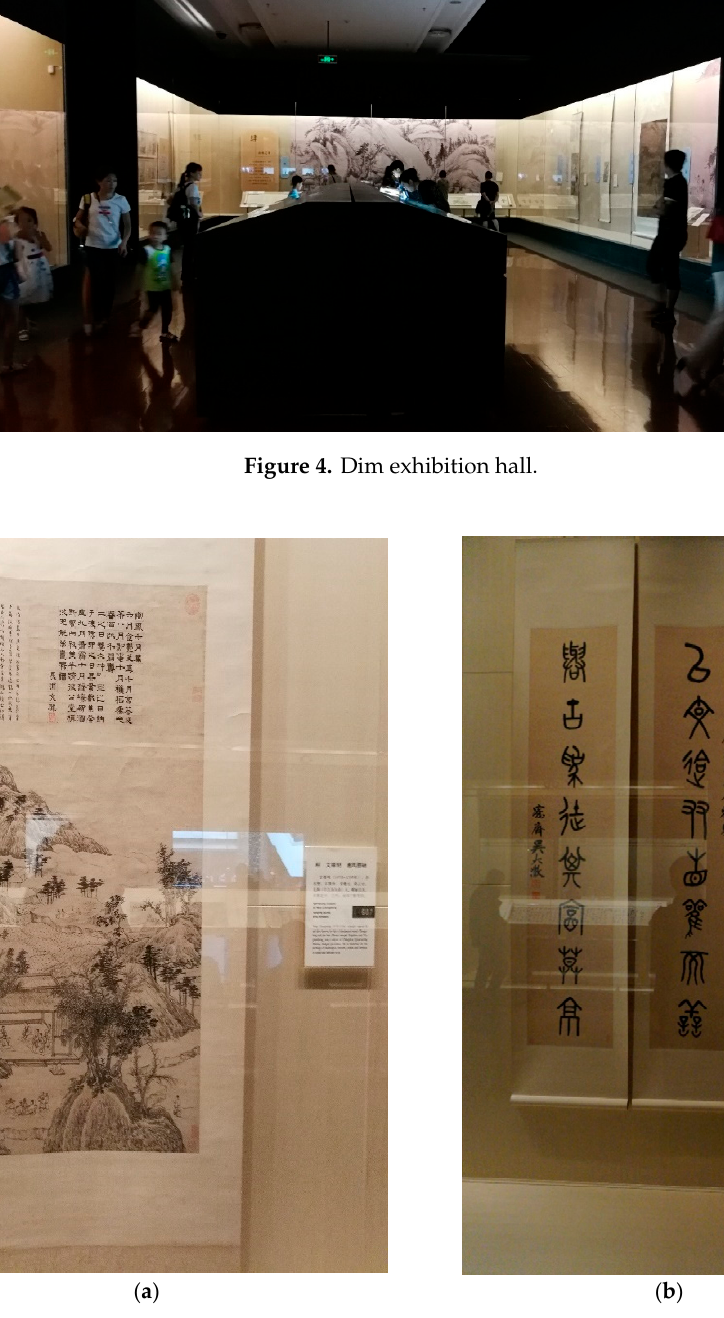
reflected glare; ( b ) Second reflected glare.